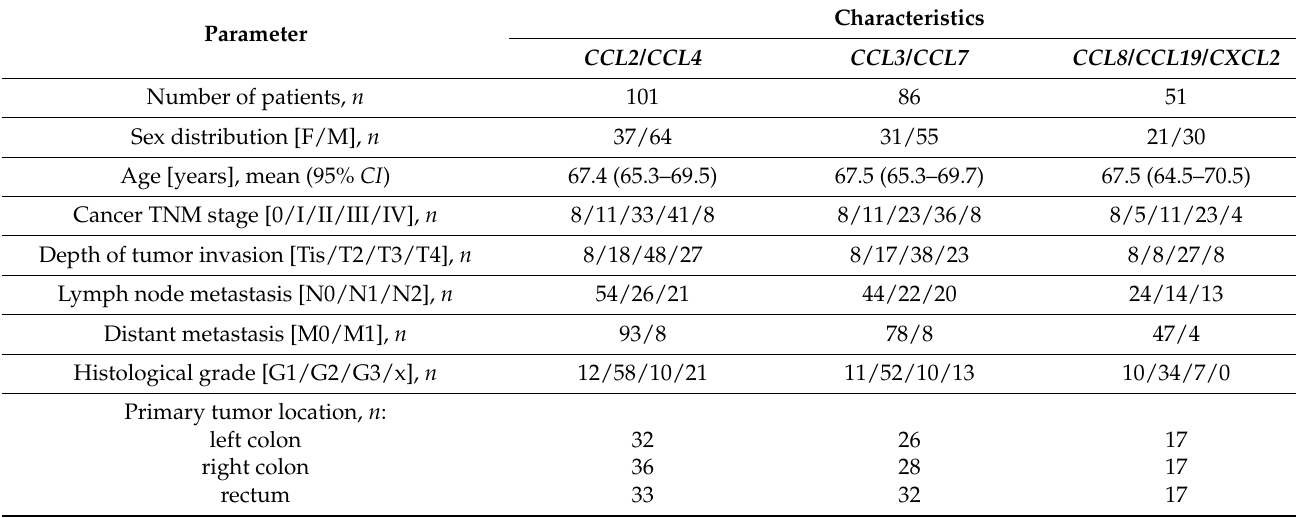
Table 3. Characteristics of the patients with colorectal